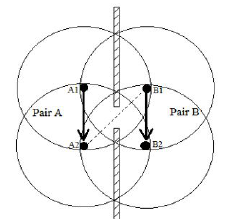
Figure 2: Tow pairs scenario (Scenario 1).